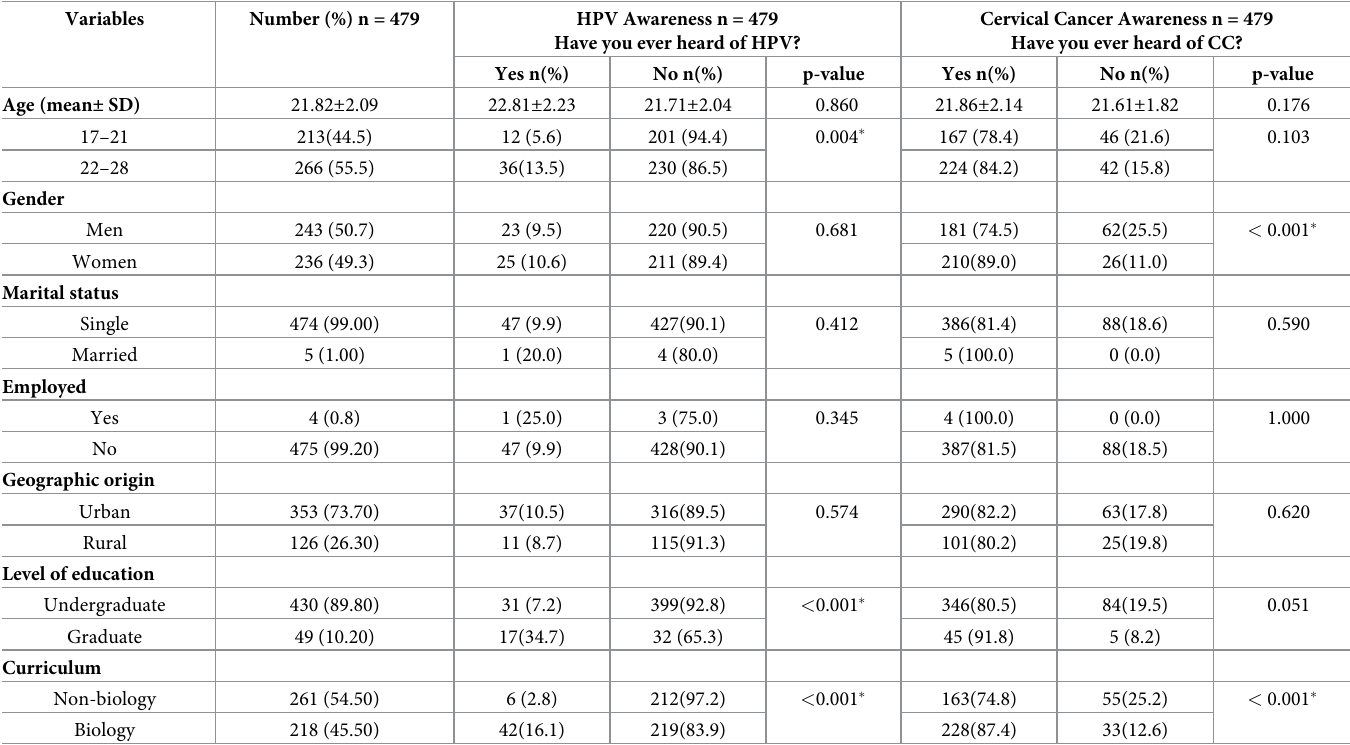
Table 1. Characteristics of the population in relation to the awareness of HPV infection and cervical cancer.